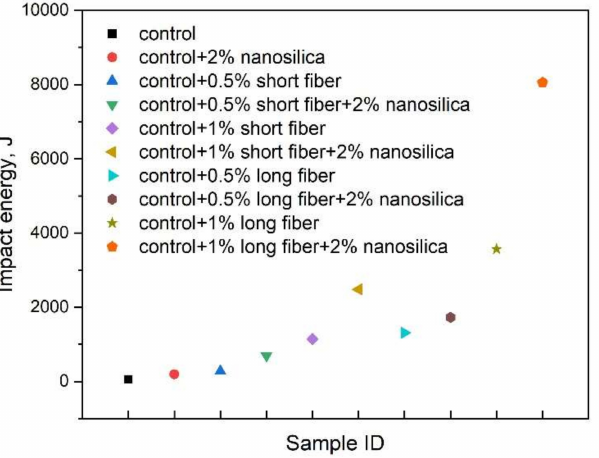
Figure 6. Impact energy of SCAAM samples (reproduced from [101]).